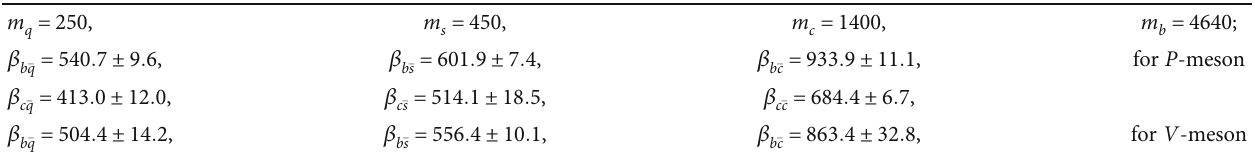
Table 1: The values of constituent quark masses and Gaussian parameters (in units of MeV) obtained by fi tting to the data of decay constants [101, 102], where q = u , d .